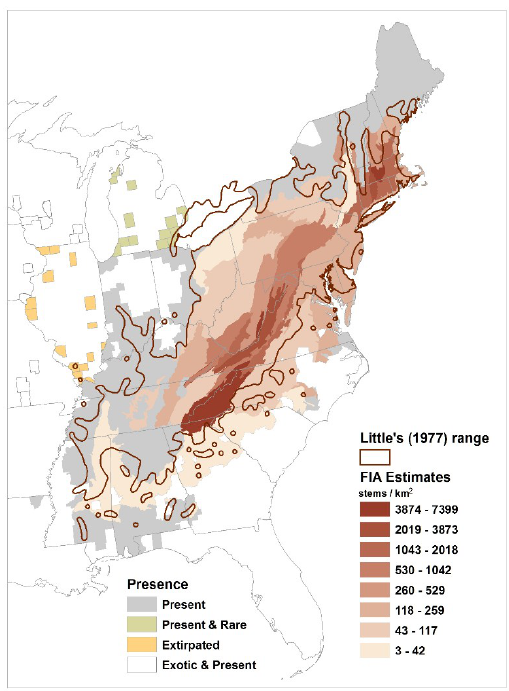
Figure 2. Geographic distribution of surviving Castanea dentata populations, with presence data taken from the Biota of North America (Kartesz 2013) and stem densities estimated from the Forest Inventory and Analysis (FIA) data. Table 1. FIA state evaluation groups used in the estimation of chestnut populations. States listed in italics have no chestnuts in the FIA database.